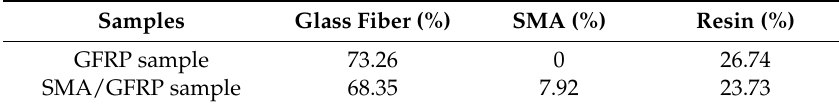
Table 2. The mass fractions of different components in the